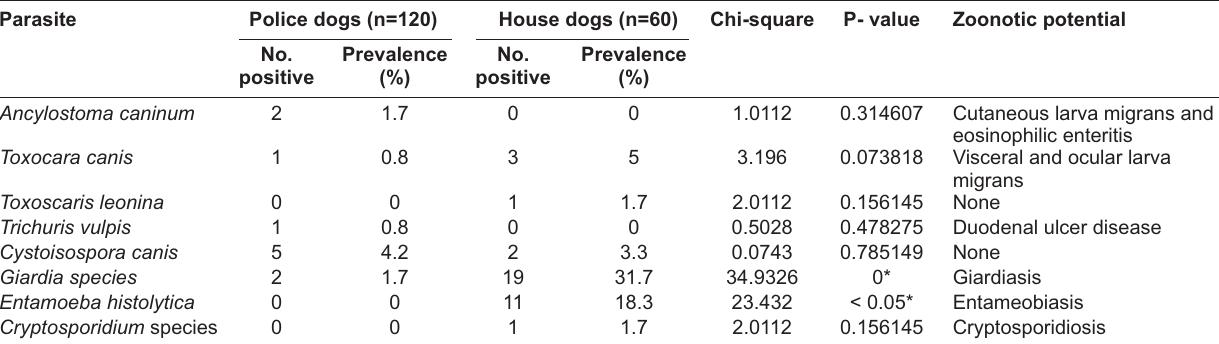
Table-1: Prevalence of enteric parasite species detected in police and house dogs feces.